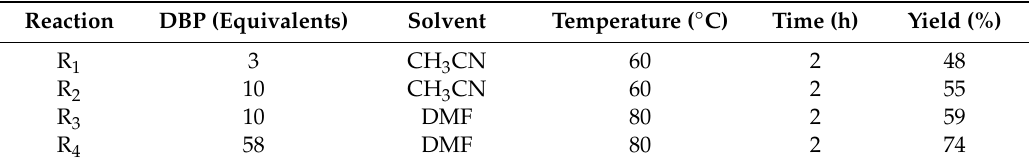
Table 1. Reaction conditions for the preparation of berberine derivative 3 (1 equivalent of substrate, no base